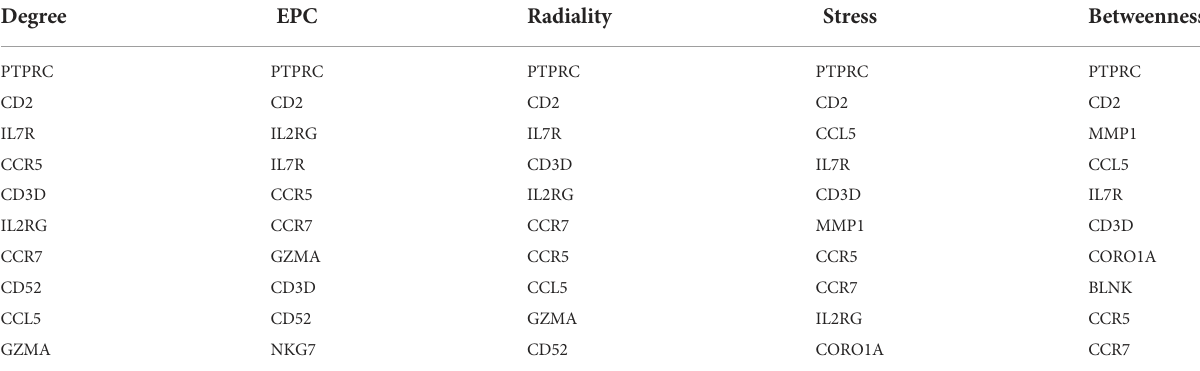
TABLE 1 The top 10 genes in 5